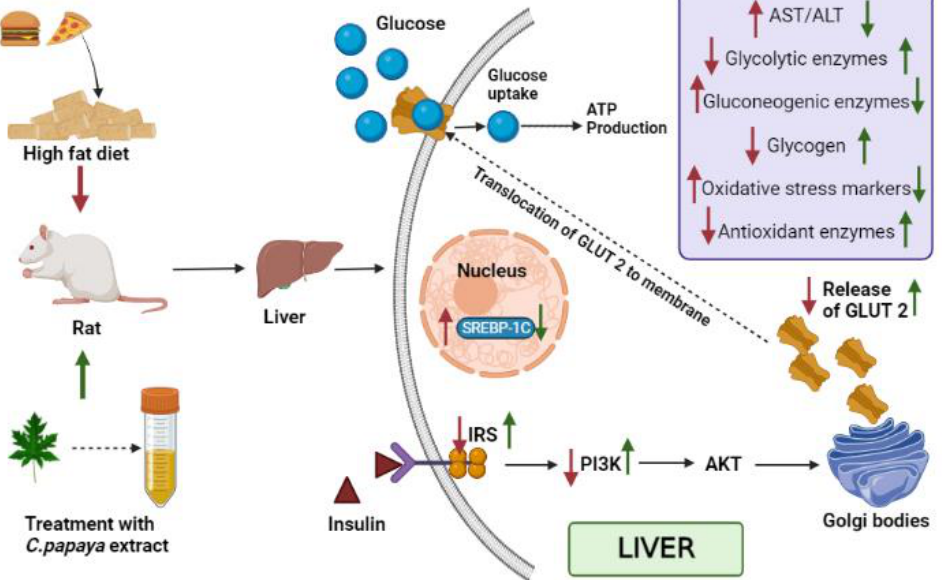
Figure 16. Summarizes the mechanisms of action of C. papaya leaf extract on IRS-2/PI3K/Akt/GLUT2. Signaling in hepatocytes. Red arrow indicates HFD-STZ-induced insulin resistance and metabolic dysfunction, while green arrow represents the therapeutic effects of C. papaya in the liver.